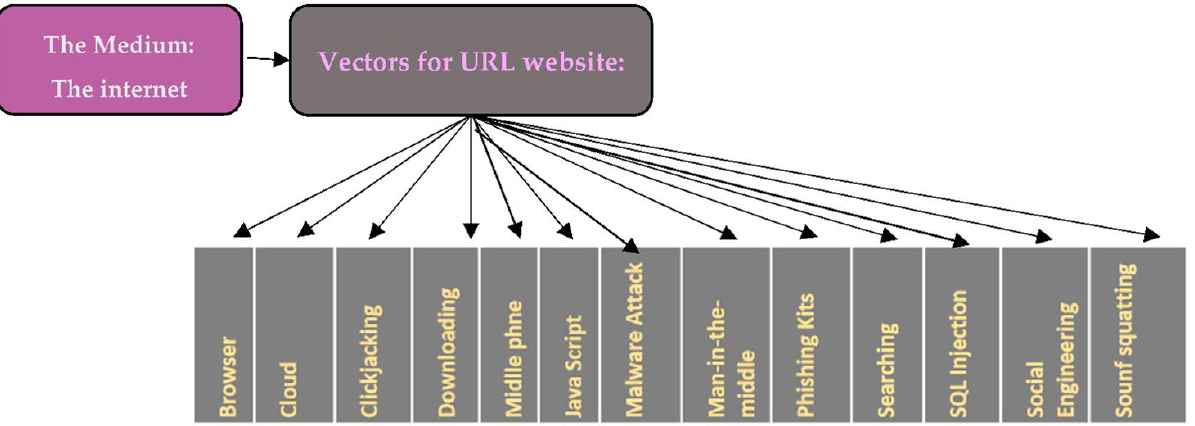
Figure 2. The join link between the URL phishing components.